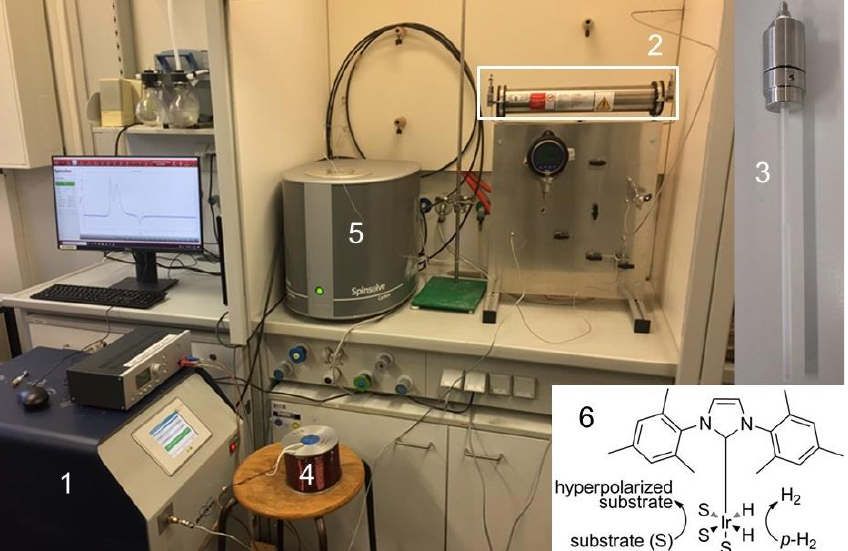
Figure 1. Overview of the high-pressure p -H 2 SABRE setup: para- hydrogen generator (1), high-pressure cylinder (2), high-pressure sapphire tube (not shown to scale for a better view) (3), electromagnet (4), benchtop NMR device (5), along with the SABRE polarization transfer mechanism in the iridium-based catalyst employed in this study (6).